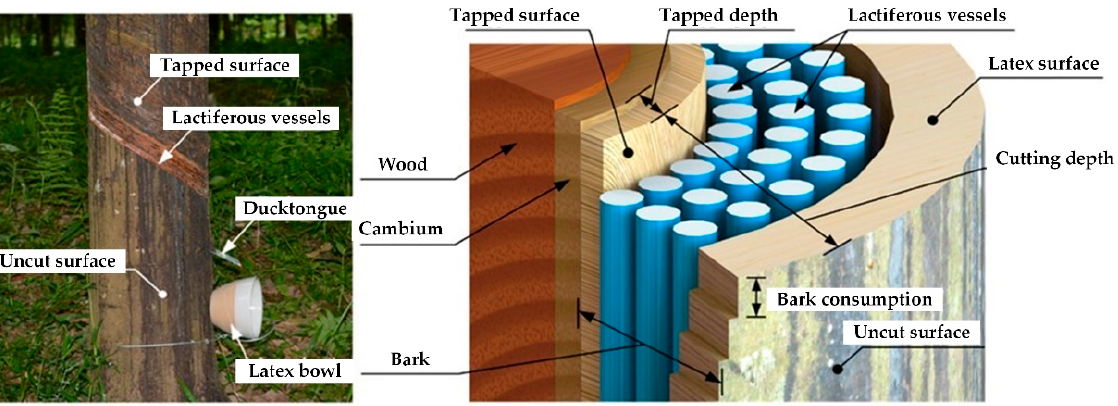
Figure 1. Partial views of a rubber tree trunk [18] .